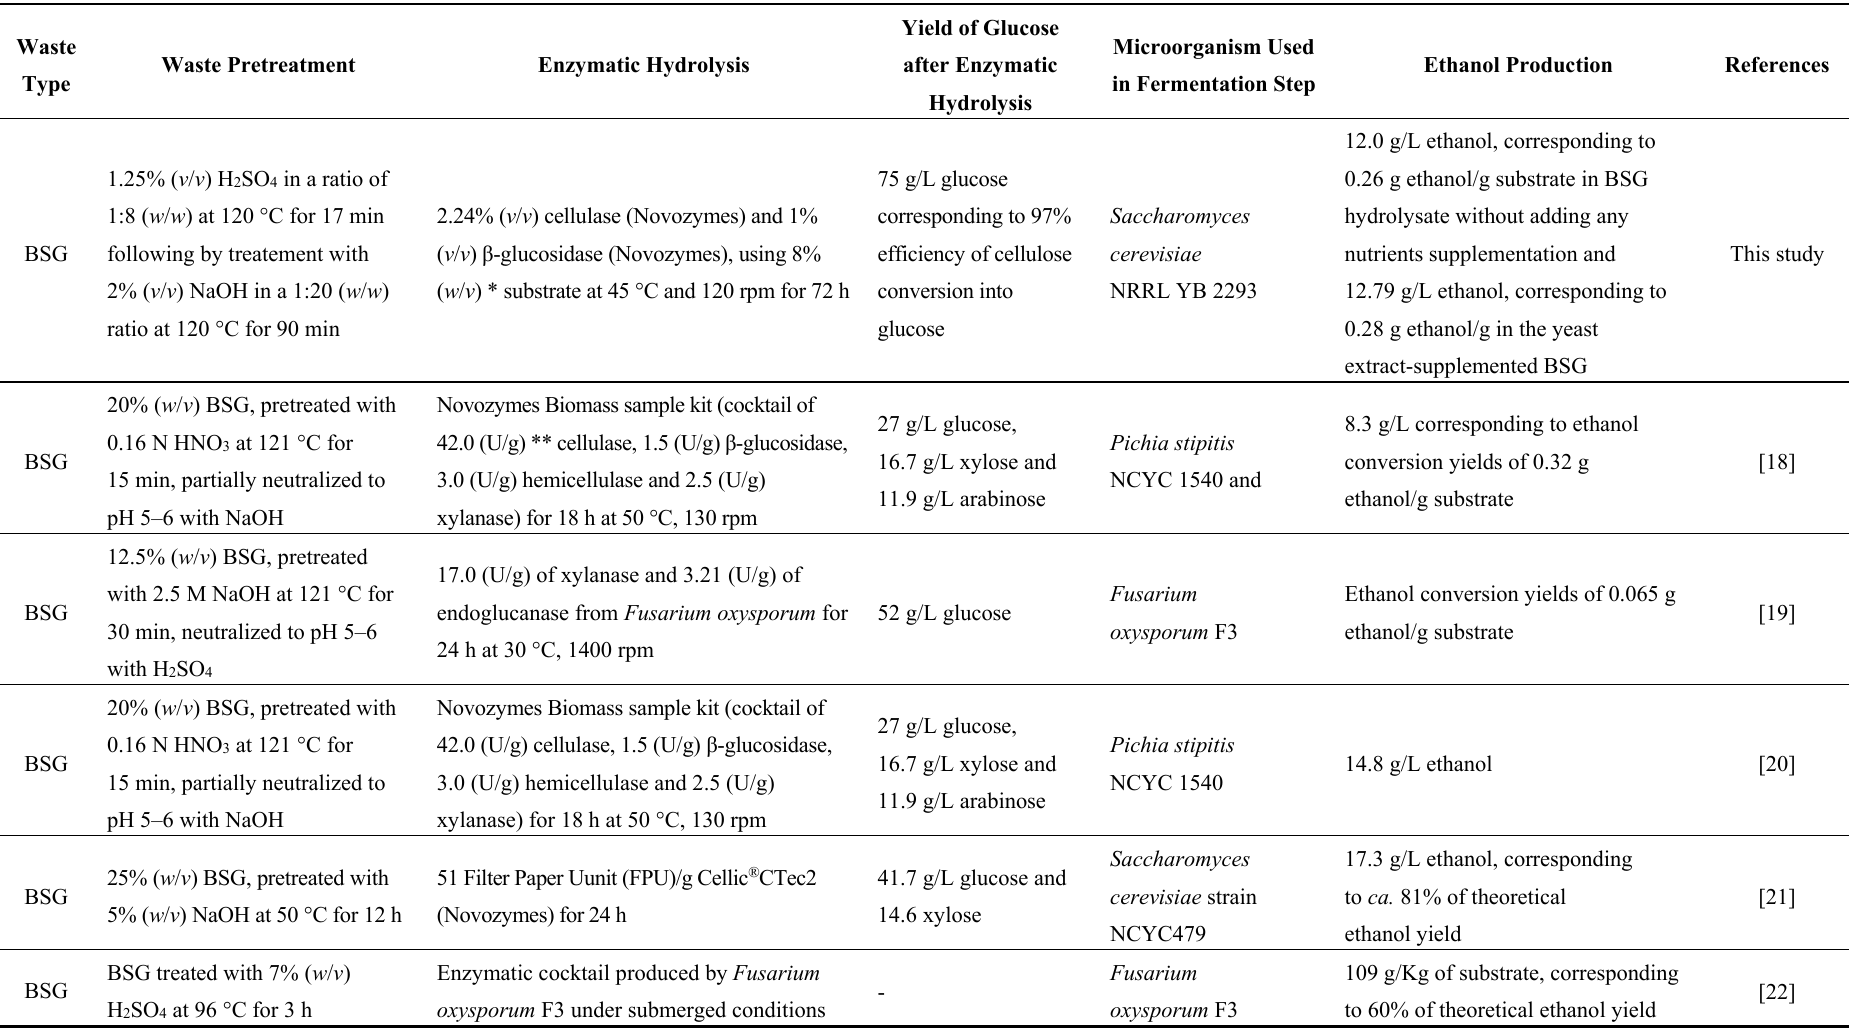
Table 3. Ethanol production from BSG